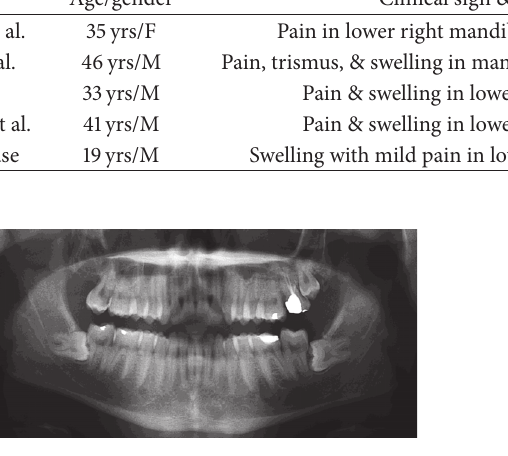
Figure 1: Orthopantomograph shows a well-circumscribed radiolu- cent mass attached to the lateral root surface of impacted permanent left mandibular first molar.